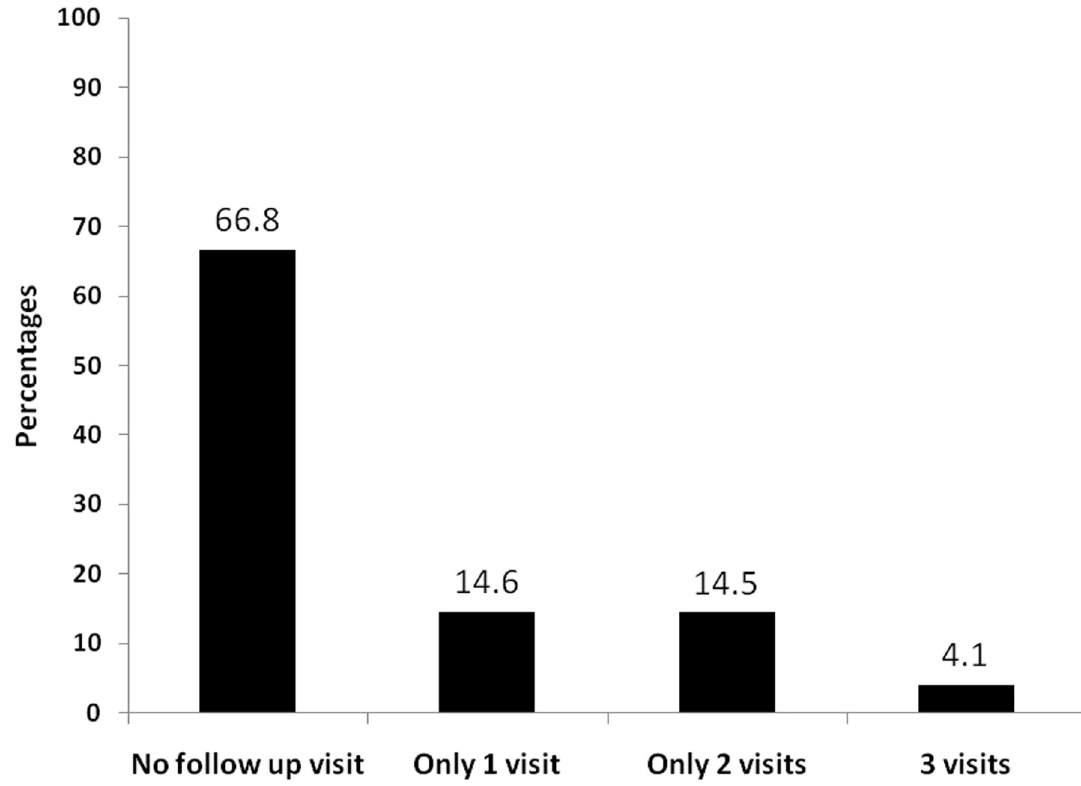
Fig 2. Pattern of follow up of patients diagnosed and registered with hypertension or diabetes or both in 5 selected townships implementing PEN project, Myanmar, between May- October 2017.